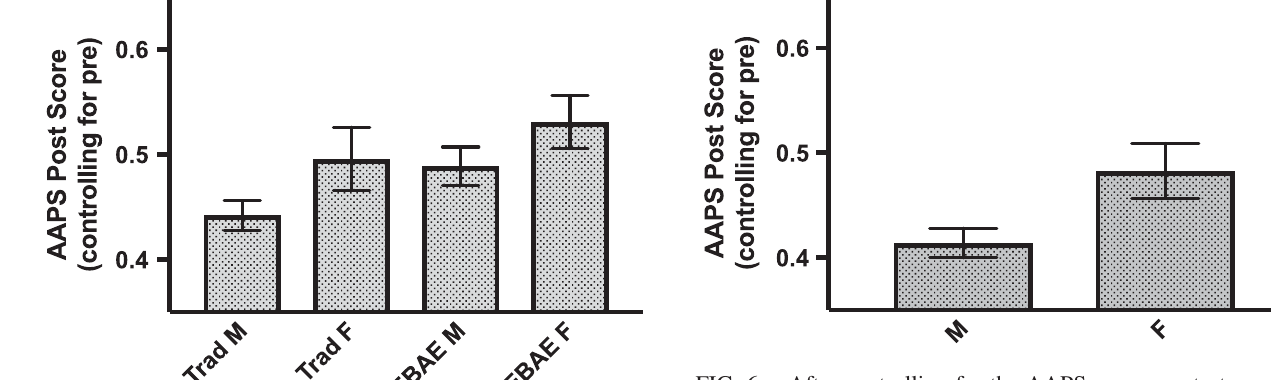
FIG. 6. After controlling for the AAPS survey pretest score in second semester classes for gender, there are statistically signifi- cant differences in AAPS survey post-test scores with female students outperforming male students [ F ð 2 ; 250 Þ ¼ 59 . 867 ; p < 0 . 001 ]. Error bars represent standard